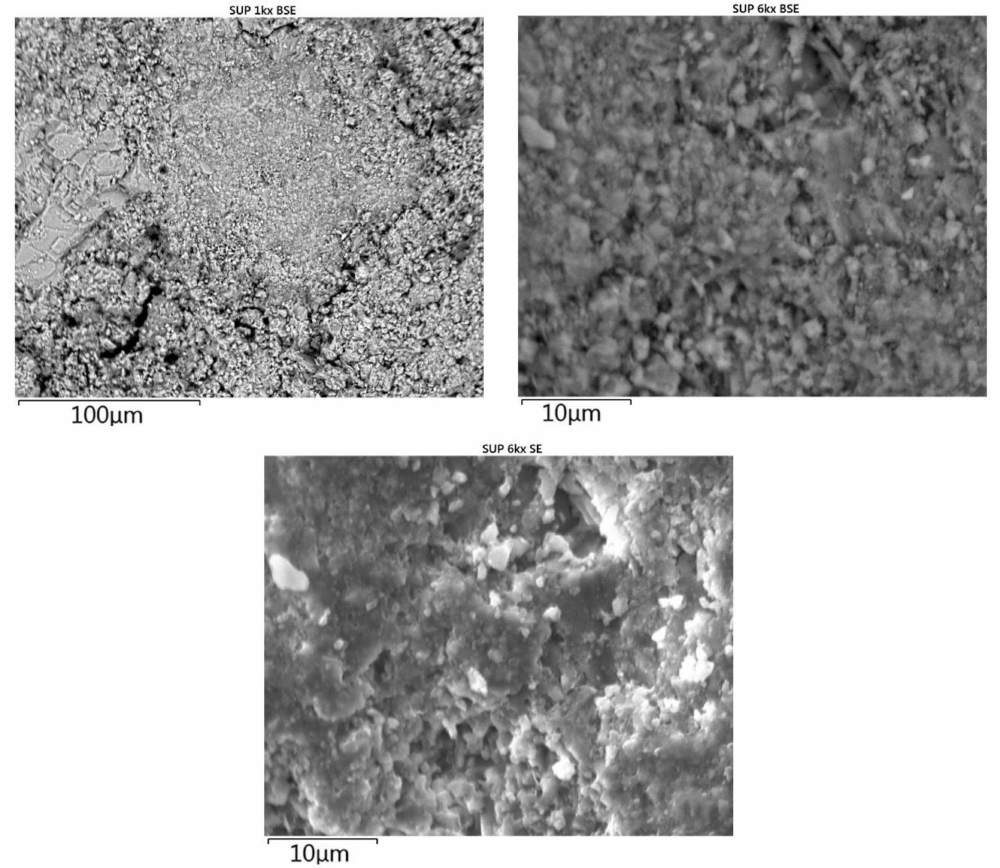
Figure 8. SEM-EDS images: Morphology of the sample surface after application of the NSO product (University of Bari Aldo